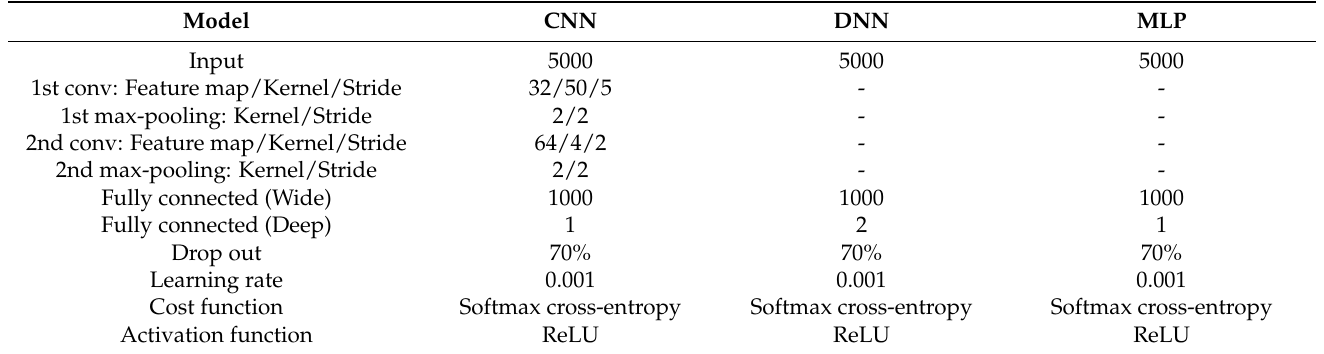
Table 4. Parameters used to train each model.